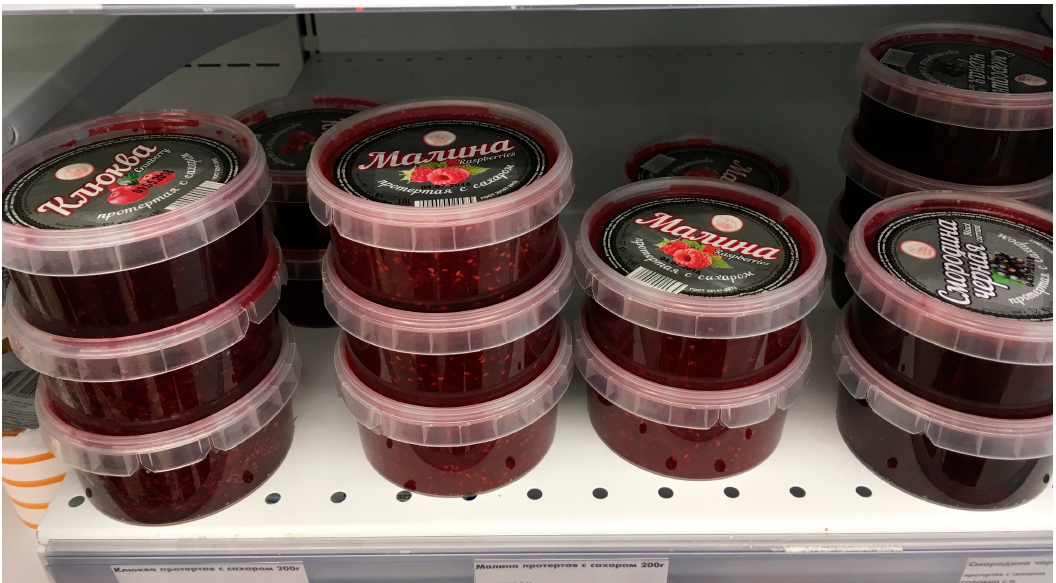
Figure 10. Cranberry, raspberry and black currant jams sold in a convenience store, Petrozavodsk.